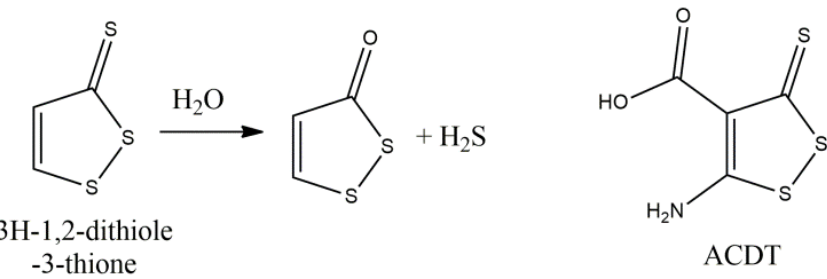
Figure 9. Hydrogen sulfide donating effect of 3H-1,2-ditione-3-thione and its derivative